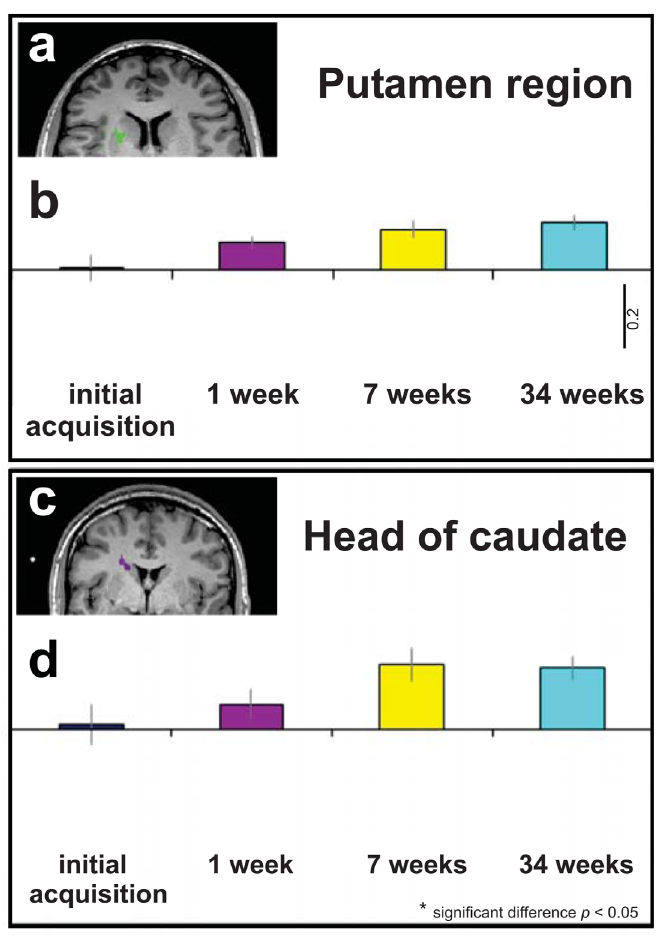
scans in the region identified as right putamen. No significant changes were found in this region across scans. c , Music-visualization task: Caudate region (x = 18, y = -4, z = 26). d , Average BOLD signals of each of the four scans in the region identified as right caudate. All error bars represent the s.e.m. Scale bar represents 0.2 percentage BOLD signal